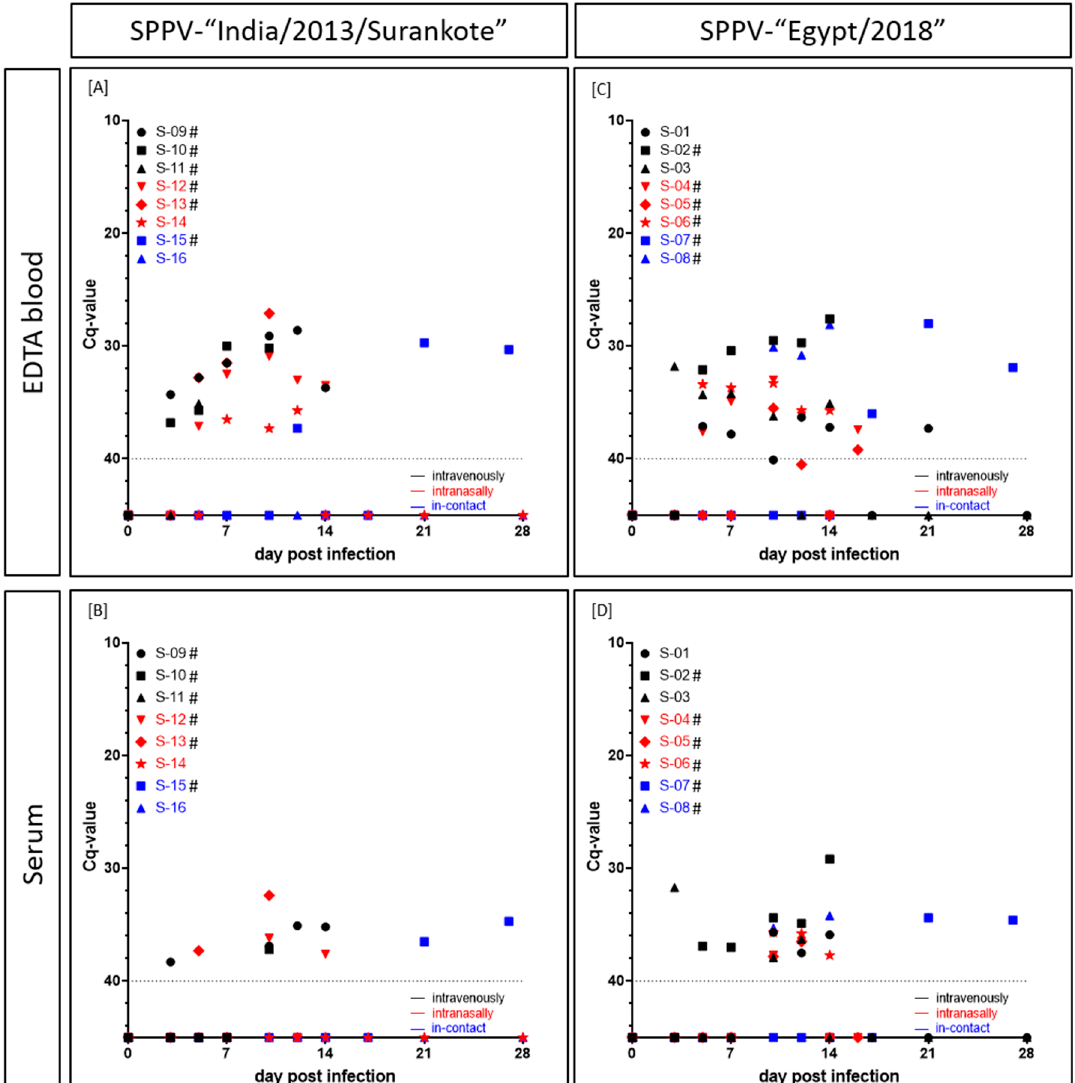
Figure 3. Cell-associated as well as cell-free viremia (Cq-values) of sheep experimentally infected with either ( A , B ) SPPV-“India/2013/Surankote” or ( C , D ) SPPV-“Egypt/2018”. EDTA blood and serum samples were examined using the pan-capripox real-time qPCR. Thereby, ( A , C ) cell-associated and ( B , D ) cell-free viremia was analyzed. Animals were inoculated via three different routes: intravenous infection (black), intranasal infection (red) and transmission between infected and naïve animals (blue). Cut-off was set at Cq 40.0. # displays animals that were euthanized before the end of the study due to ethical reasons.